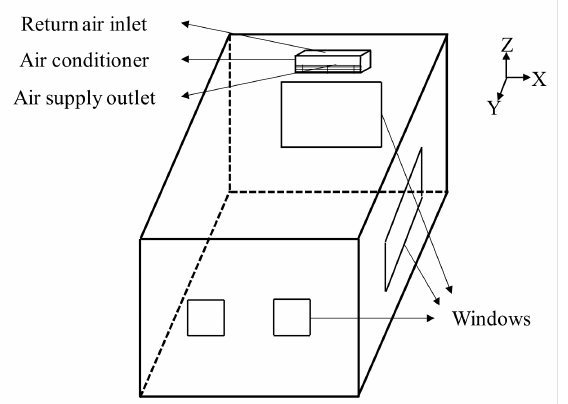
Figure 4. Geometric model of an air-conditioned room.